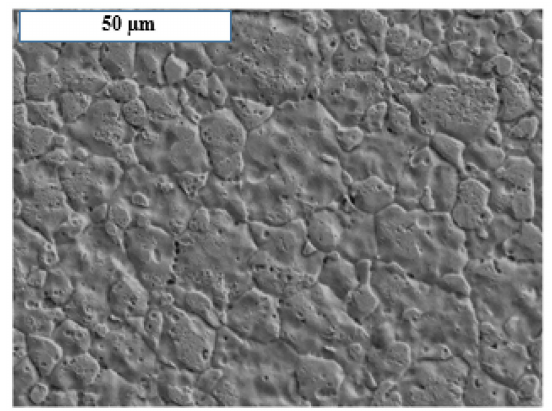
Figure 2. SEM of Nimonic 263 sample prior to application of the paint